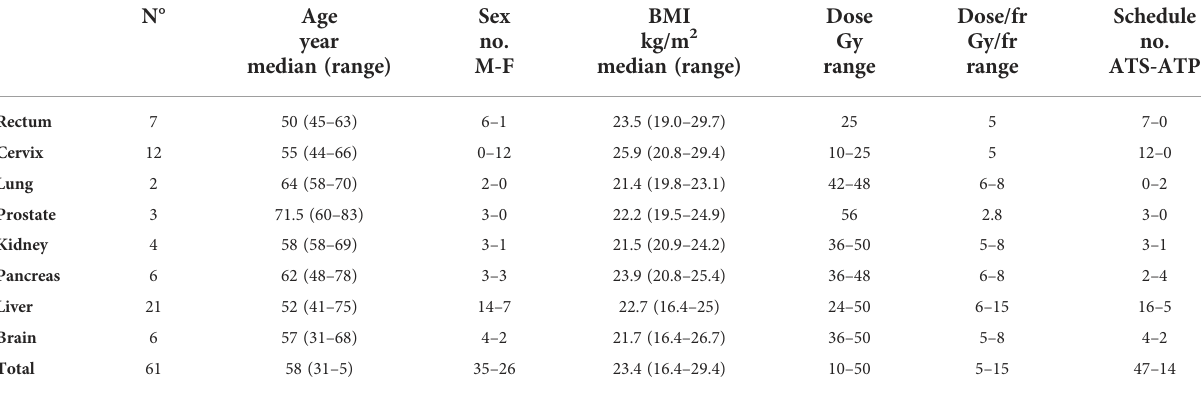
TABLE 1 Patient characteristics, tumor site, and adopted treatment